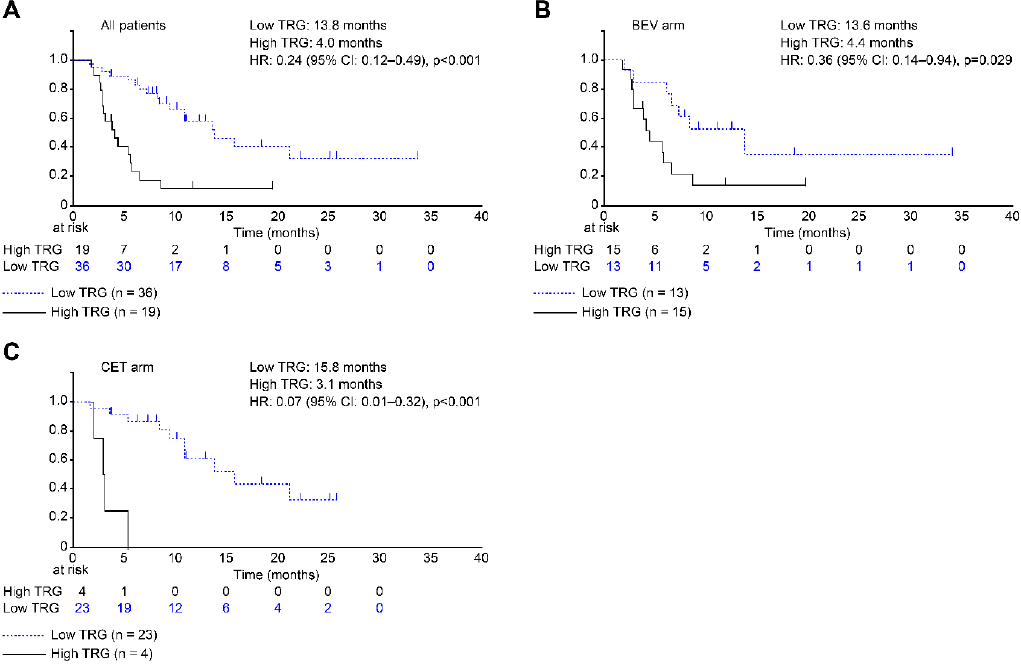
Figure 3. Kaplan–Meier curves for recurrence-free survival (RFS, time to relapse after resection) based on the tumor regression grade (TRG). Curves are shown for all patients ( A ), patients in the bevacizumab (BEV) arm ( B ), and patients in the cetuximab (CET) arm ( C ). Relative to patients with high TRG, those with low TRG had significantly better RFS (median: 4.0 vs. 13.8 months, hazard ratio (HR): 0.24; 95 confidence interval (CI): 0.12–0.49; p < 0.001). Similarly, relative to high TRG, low TRG was associated with significantly better RFS in the BEV arm (median: 4.4 vs. 13.6 months; HR: 0.36; 95% CI: 0.14–0.94; p = 0.029) and in the CET arm (median: 3.1 vs. 15.8 months; HR: 0.07; 95% CI: 0.01–0.32; p < 0.001).